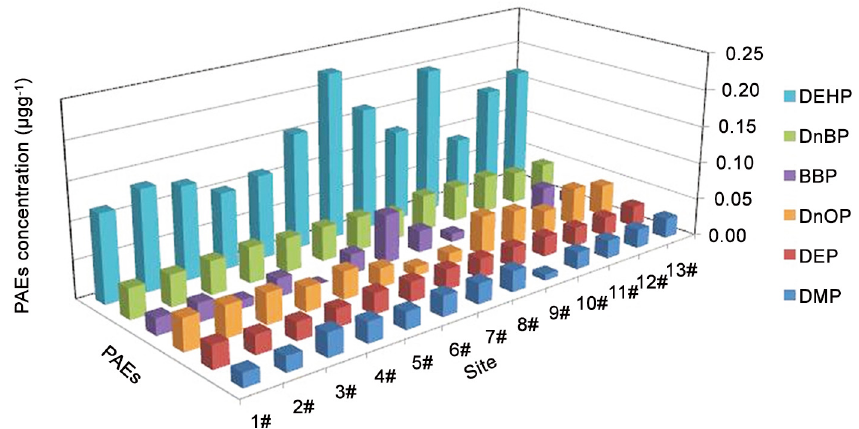
Fig 2. Concentrations of 6 PAEs congeners in the agricultural soils along the